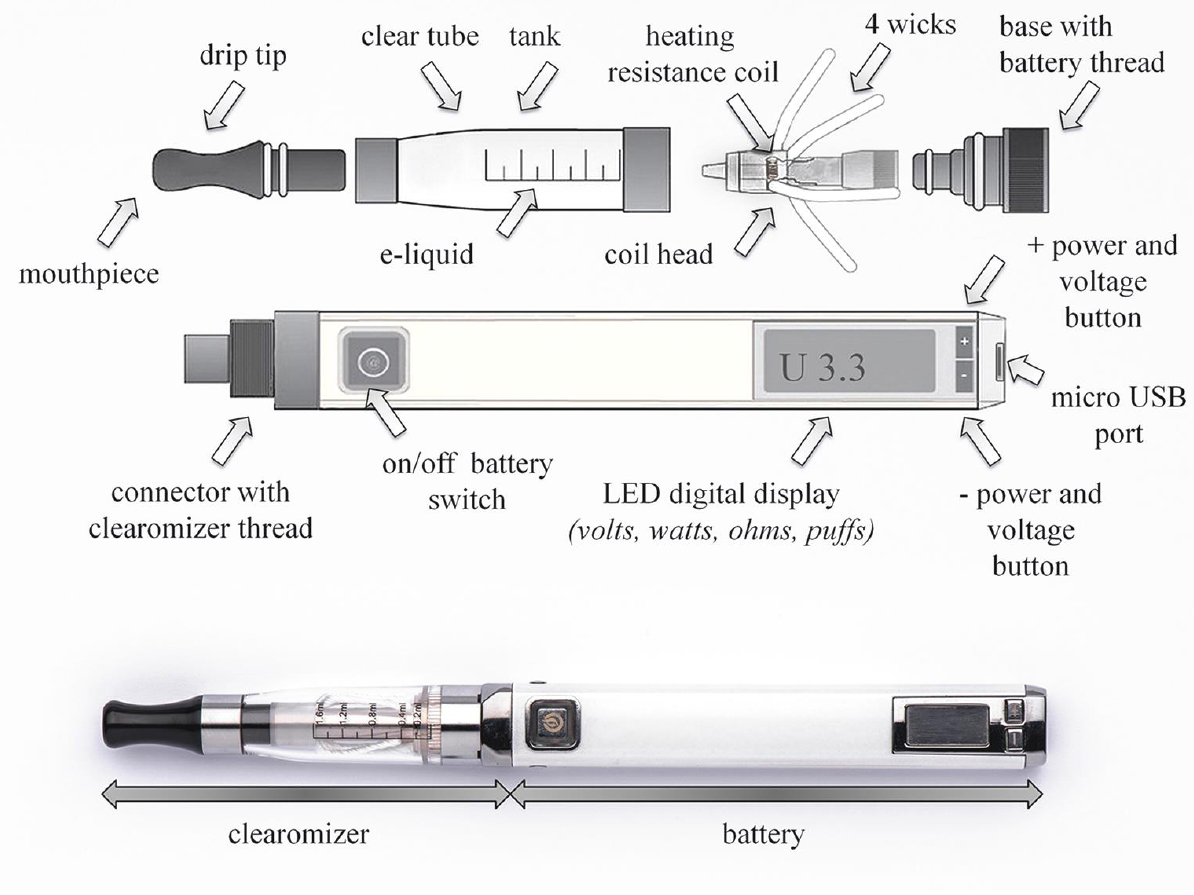
Figure 1. Microprocessor-controlled, variable-voltage/wattage, personal electronic-cigarette with LED digital display (volts or watts, puff count, ohmic resistance), equipped with a transparent clearomizer and changeable dual-coil head. Vaping cannabis requires an e- cigarette model of this type, offering a wide range of settings (power, voltage adjustments) and the option of using different resistance coils. The presence, number, and positioning of wicks are also